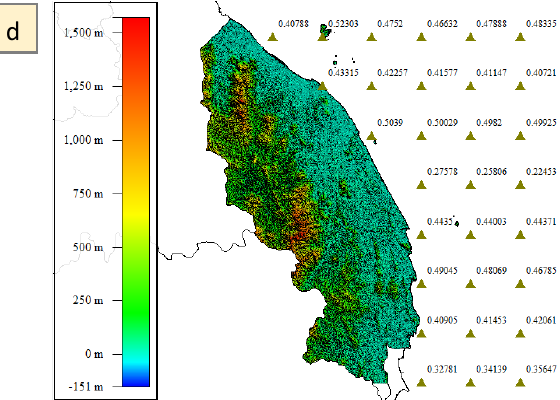
Figure 9. Maps of the distribution of sea level projection in South China Sea around Terengganu coastline in year (a) 2040, (b) 2060, (c) 2080, and (d) 2100, in unit